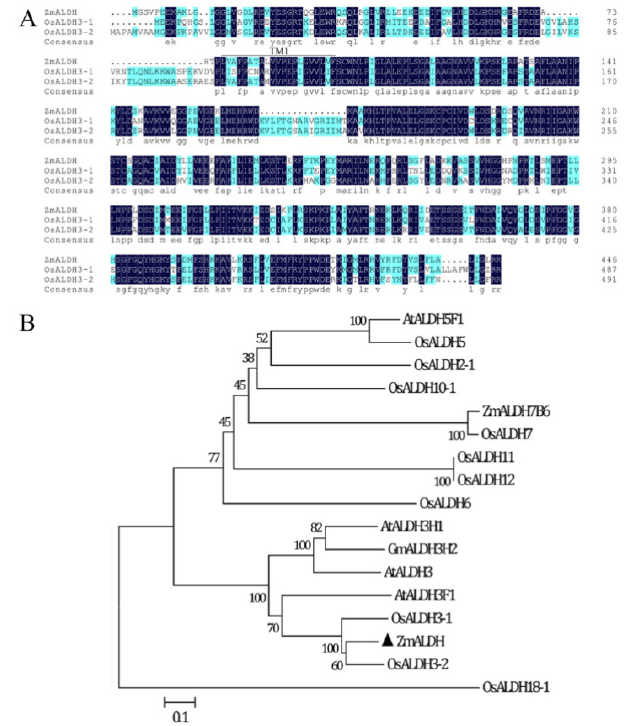
Figure 1. Sequence and phylogenetic analysis of ZmALDH and other known ALDH proteins: ( A ) Multiple sequence amino acid alignment (DNAMAN) of ZmALDH (AQK73130), OsALDH3-1 (XP_015623875), and OsALDH3-2 (XP_015623591); ( B ) Phylogenetic relationships of ZmALDH and previously published ALDH proteins. Unrooted NJ trees were generated using MEGA 6.0. Bootstrap values from 1000 replicates are indicated at each